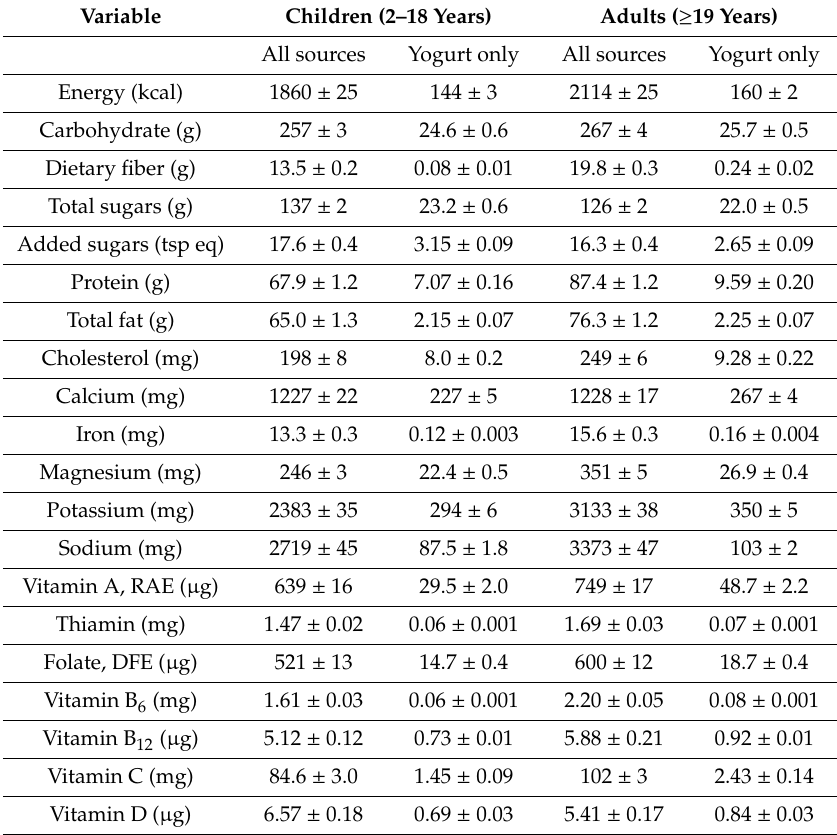
Table 1. Energy and nutrient intakes in children and adult yogurt consumers from all sources and from yogurt only (National Health and Nutrition Examination Survey (NHANES) 2001–2016, gender combined